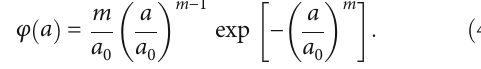
Figure 5: Shale microslice image.